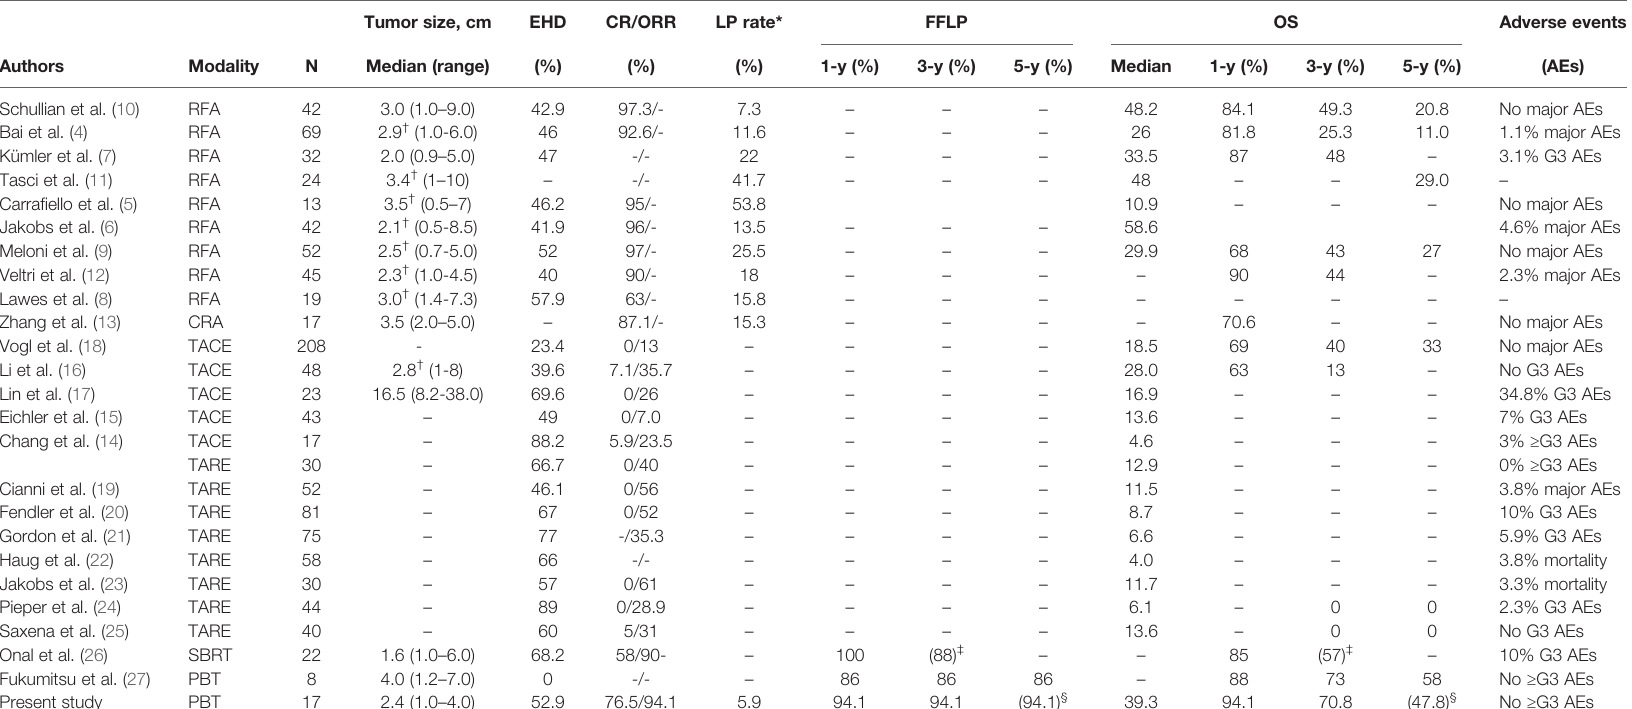
TABLE 3 | Studies on nonsurgical local treatments for liver metastasis from breast